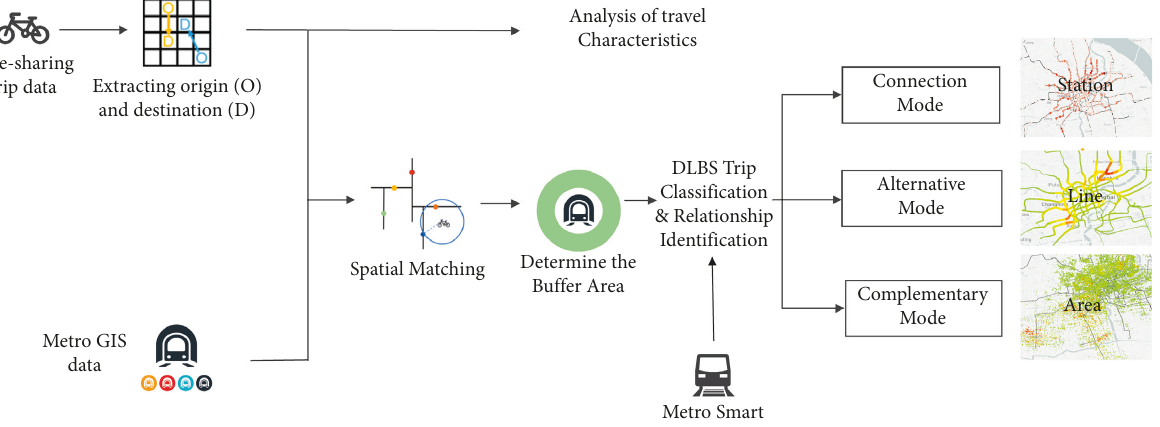
Figure 3: Methodology